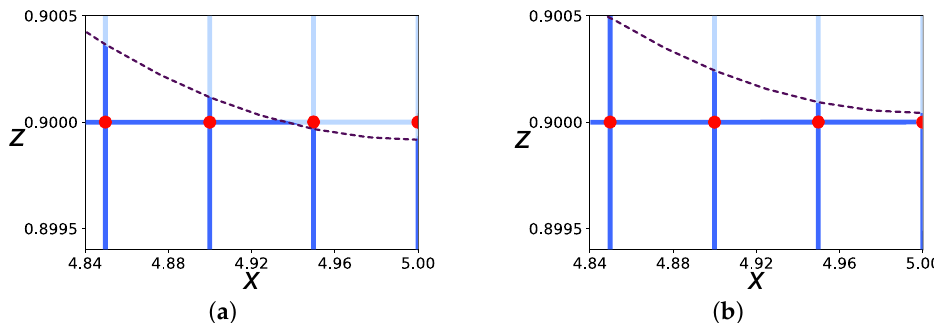
Figure 13. Two different examples of the location of the gas/liquid interface. The vertex of interface is located below ( a ) and above ( b ) the nearest horizontal capillary.